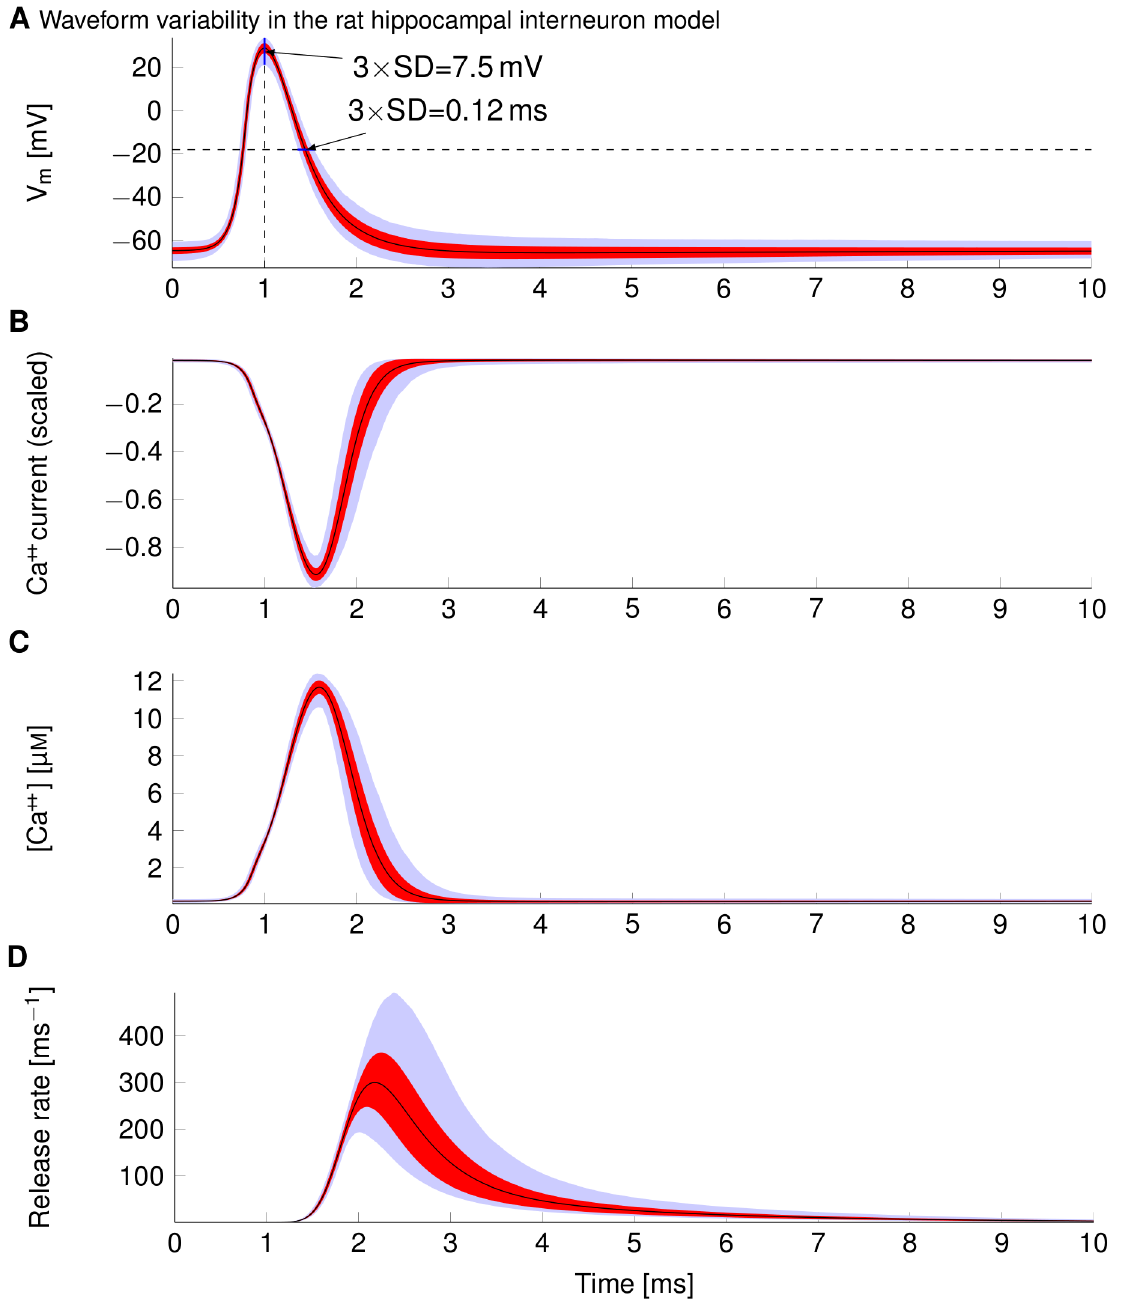
Figure 7. Variability in synaptic processes due to fluctuation in AP waveforms. For all subfigures, the mean waveform is plotted in black, SD in red, and 1%–99% quantiles in light blue. (A) Waveforms of 2000 consecutive APs arriving at the terminal end of an axon of 0.2 m m diameter rat hippocampal interneuron model axon. (B) Ca ++ current resulting from the integration of the above AP waveforms into a model of a pre-synaptic Ca ++ channel (see text for details). The current is scaled because we are only interested in its waveform. (C) Intracellular Ca ++ concentration for a large CNS synapse obtained by scaling the Ca ++ current waveform, and lengthening it. (D) Time course of vesicle release rates computed for a model of a Calyx- of-Held type synapse (see text for